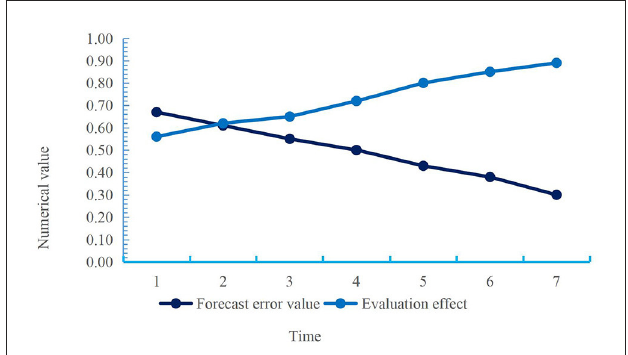
FIGURE5 Civil servants’ crisis awareness and emergency response ability under the implementation of psychological strategies.